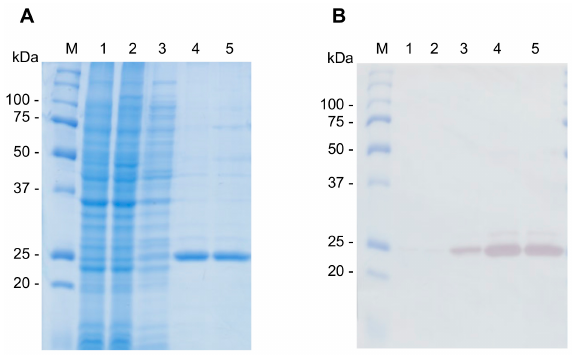
Figure 8. Expression and purification of rCsTegu20.6. The rCsTegu20.6 was detected in E. coli BL21(DE3) pLysS through SDS-PAGE staining by Coomassie brilliant blue ( A ) and Western blot with anti-polyhistidine antibody ( B ). Molecular weight marker (M), lysate of E. coli with pRSETb-CsTegu20.6 before induction (Lane 1) and after induction (Lane 2), flow through (Lane 3), purified recombinant proteins (Lanes 4 and 5).